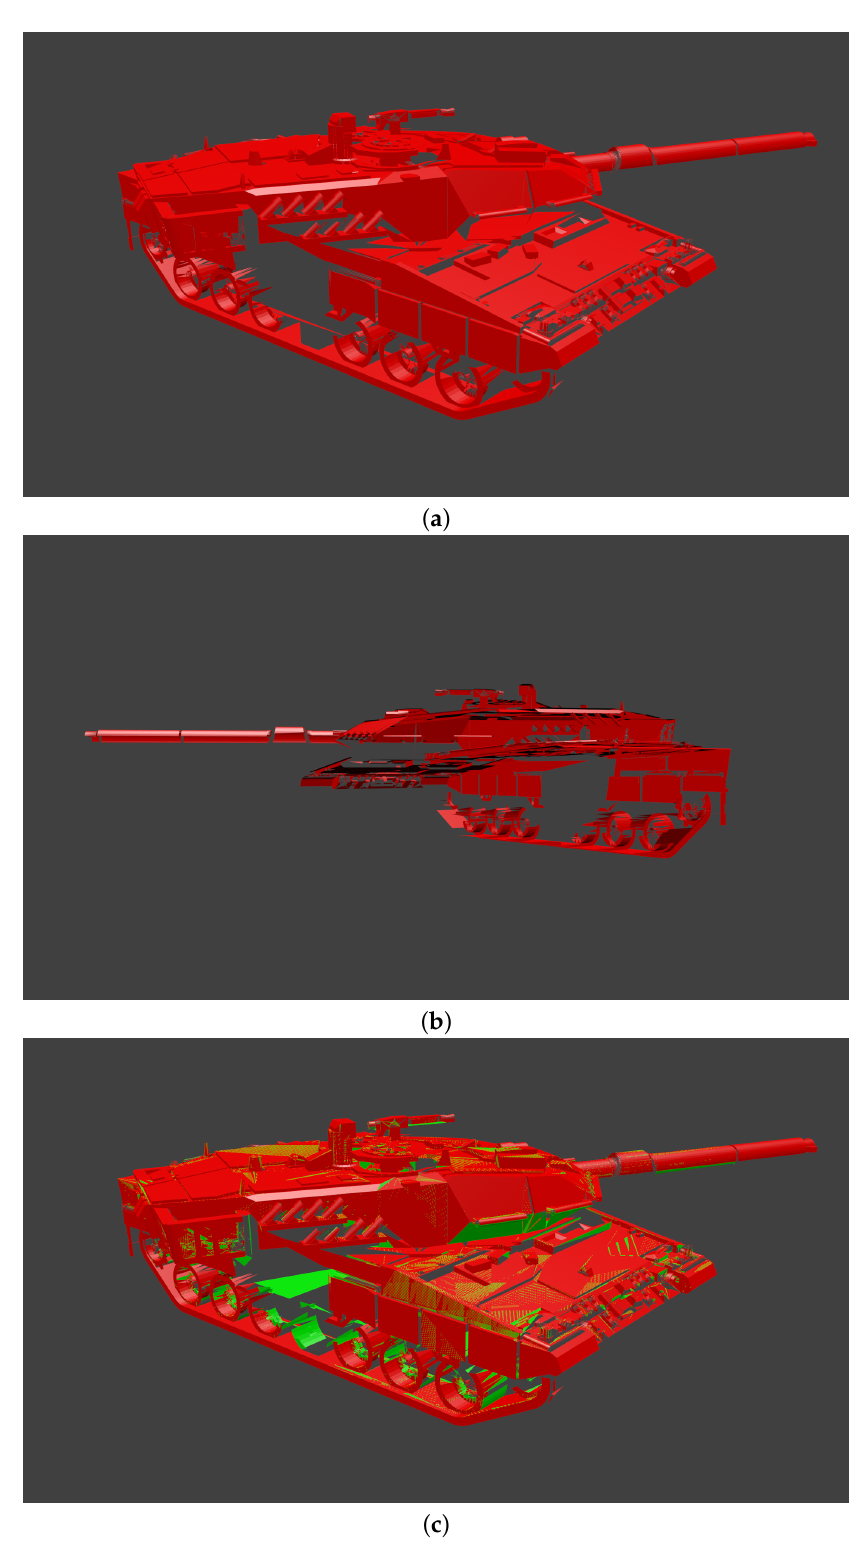
Figure 15. SARTrace results for a Leopard 2A6 model (no ground plane, illumination from upper left of ( a )). ( a ) First bounce only; ( b ) First bounce only (alternate view); ( c ) Combined result for bounces 1 and